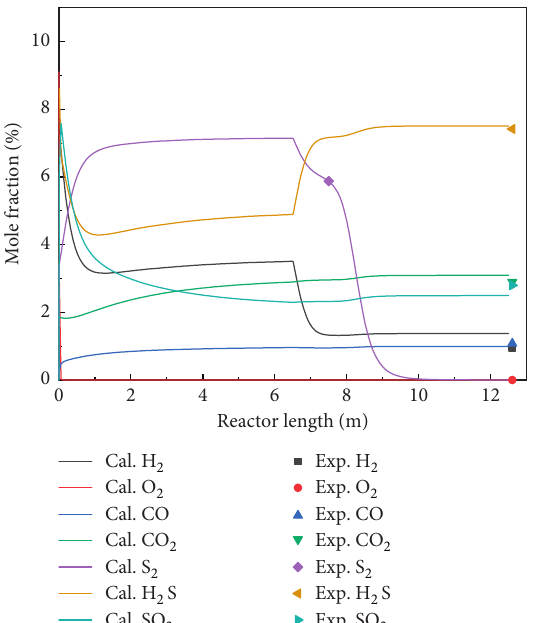
Figure 5: Gas-phase species composition along with the TR and WHB of industrial data and the calculation result.